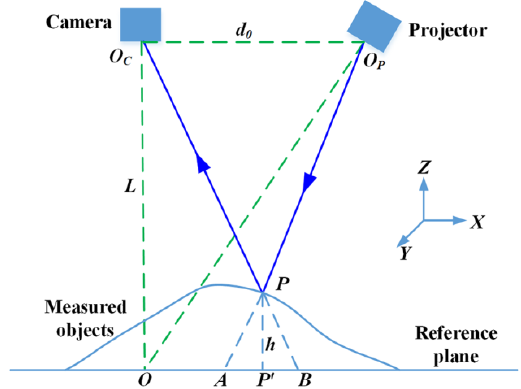
Figure 1. Fringe projection system.